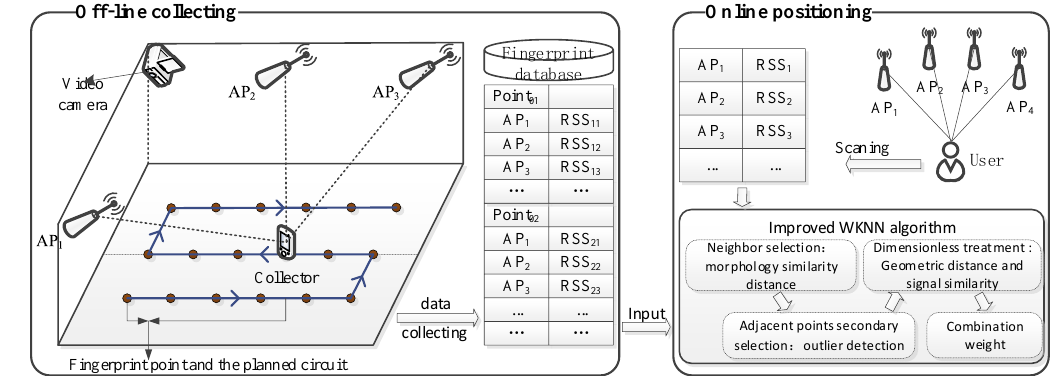
Figure 1 . Components of the proposed positioning